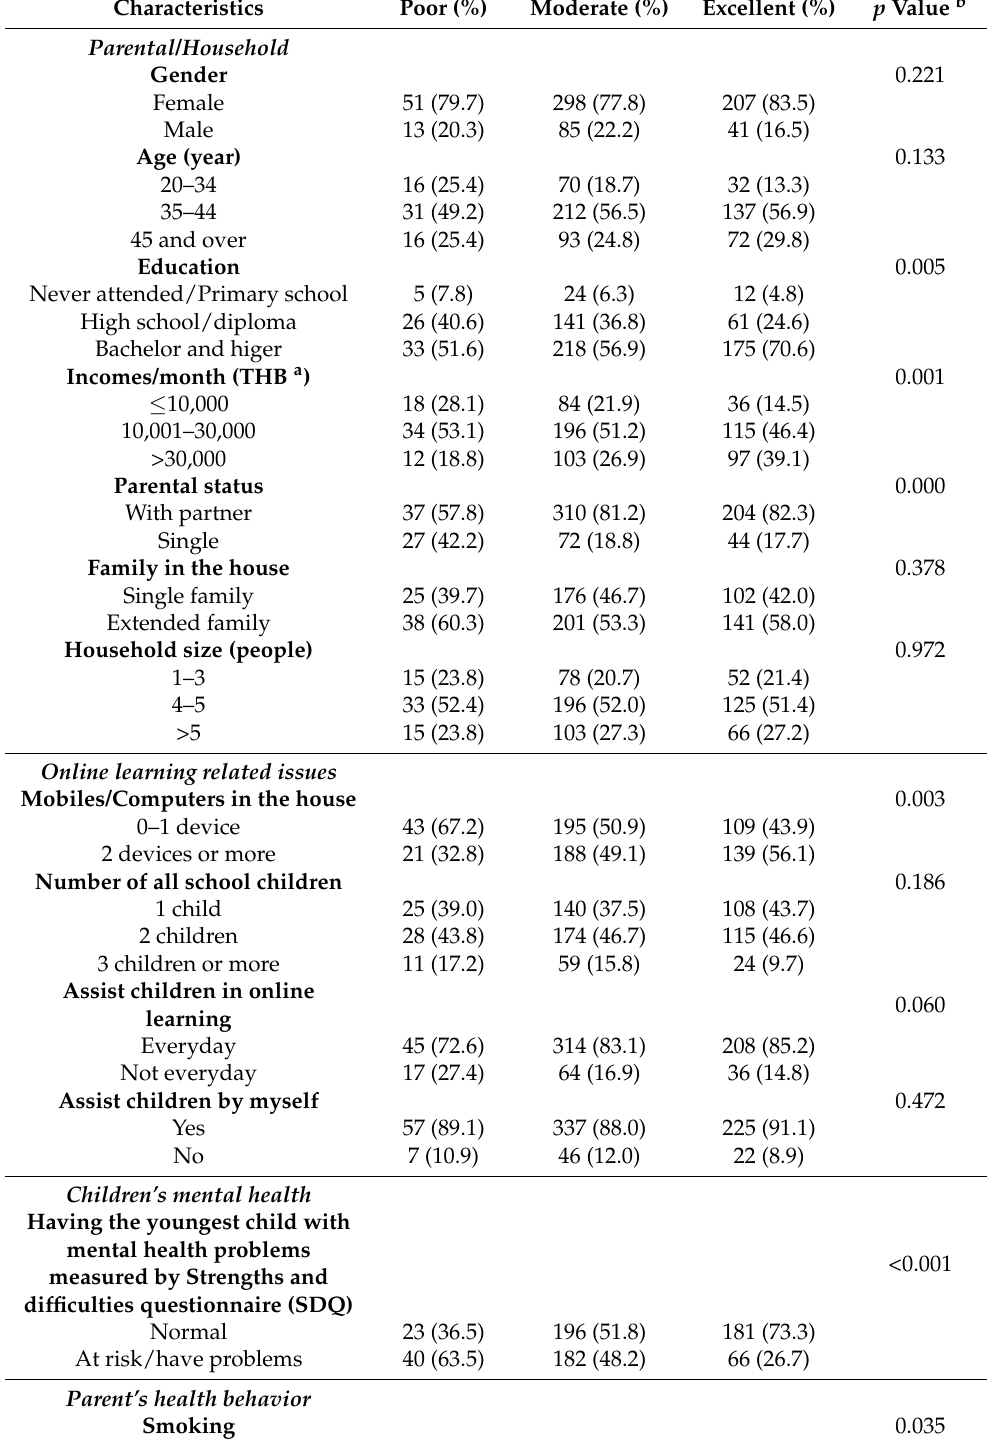
Table 3. Family health across the studied characteristics ( n =